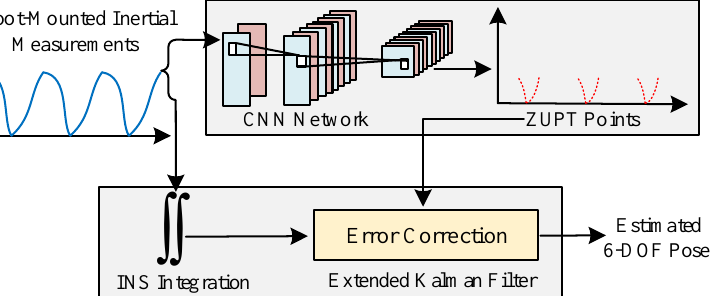
Figure 5. Block diagram of the AZUPT PDR system. Given any one of the motion types (walking, fast walking, running), AZUPT can pick ZUPT points accurately without recognition.